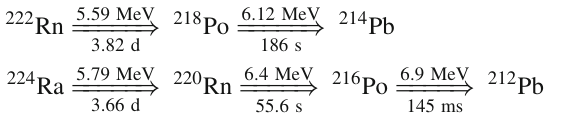
or 224 Ra (right) Q value peak (red). The spectrum of 224 Ra daughters (right, in blue) is miscalibrated due to the 220 Rn − 216 Po pile-up. These events are rejected by the pileup rejection cuts, therefore they are not 1 / 2 included in the M 1 α spectrum